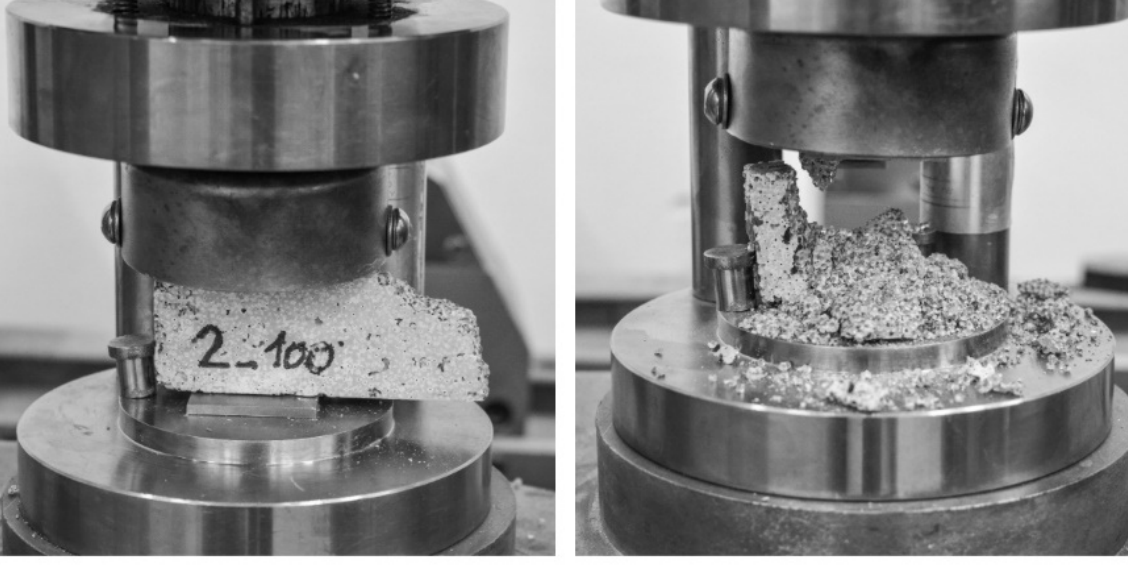
Figure 4. The compression test of specimens: The auxiliary loading device with two auxiliary platen was placed in the hydraulic testing machine with selected specimens prepared for the test (left); specimen after